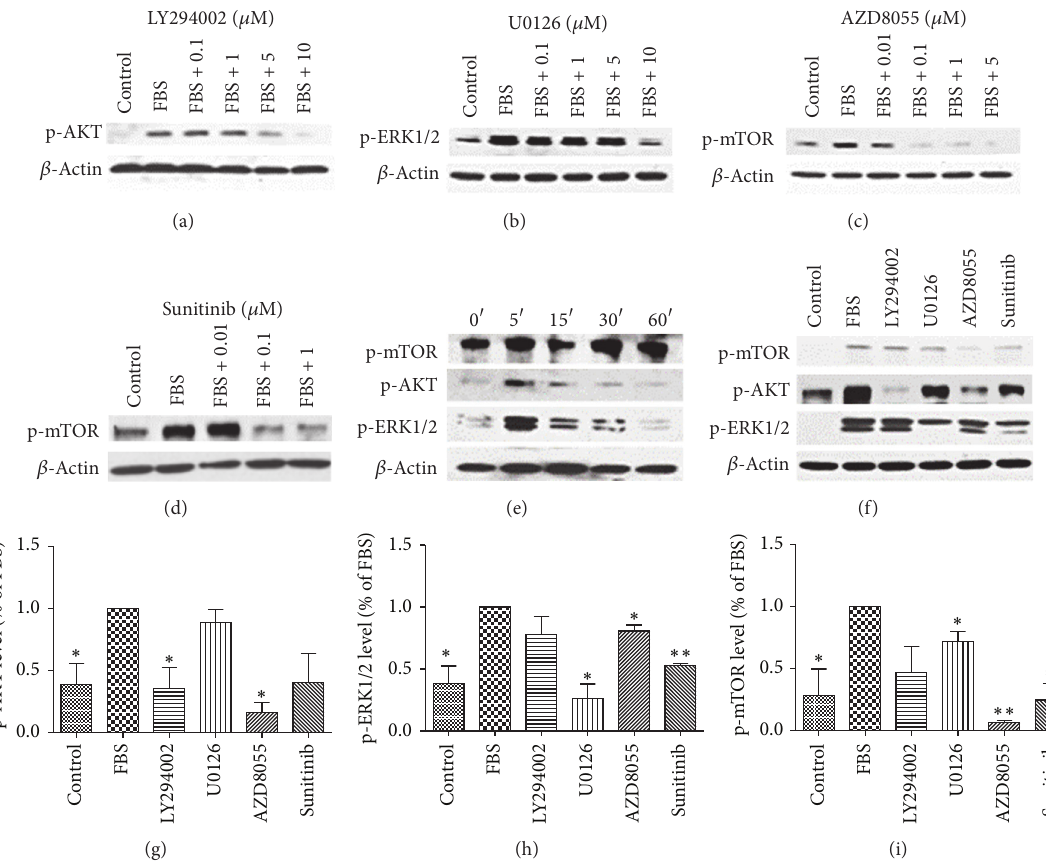
Figure 2: Effects of pathway inhibitors on phosphorylation of AKT, ERK1/2, and mTOR in human PPGL cells. (a–d) Dose-dependent inhibition of p-AKT (a), p-ERK1/2 (b), and p-mTOR (c, d) by pathway inhibitors (LY294002 (a), U0126 (b), AZD8055 (c), and sunitinib (d)). (e) Time course of phosphorylation of AKT, ERK1/2, and mTOR induced by the serum. (f) Effects of LY294002 (10 𝜇 M), U0126 (10 𝜇 M), AZD8055 (1 𝜇 M), and sunitinib (1 𝜇 M) on the phosphorylation of AKT, ERK1/2, and mTOR in human PPGL cells. 𝛽 -Actin was used as a